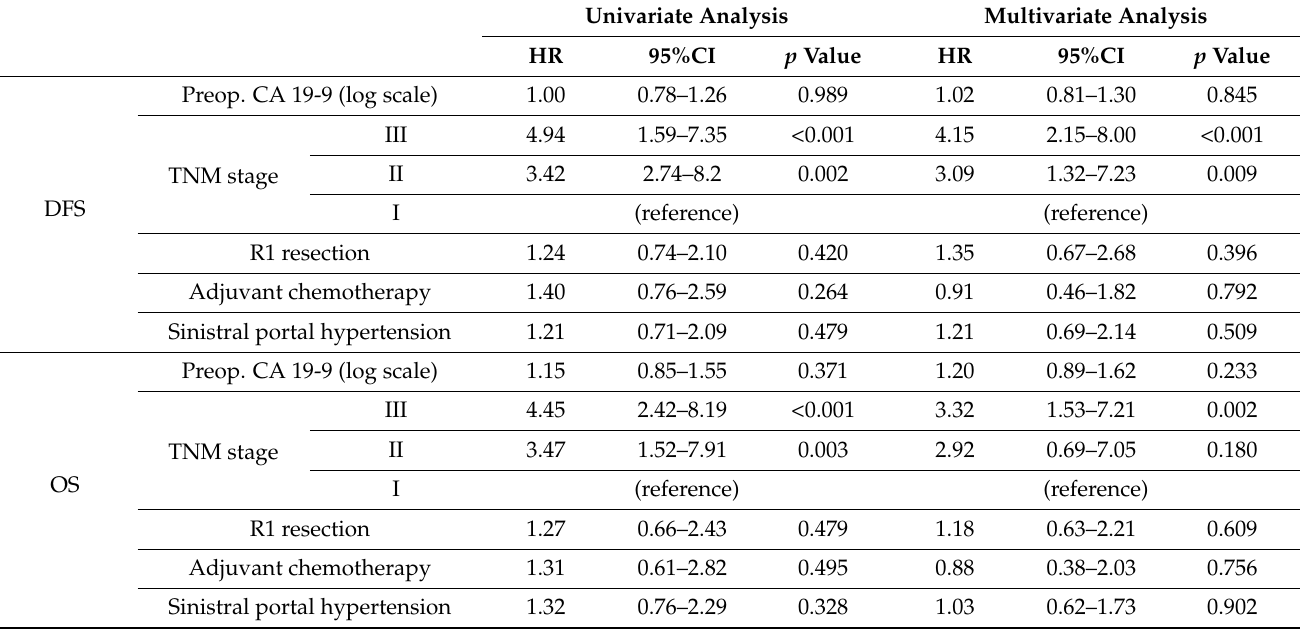
Table 5. Univariate and multivariate risk of overall